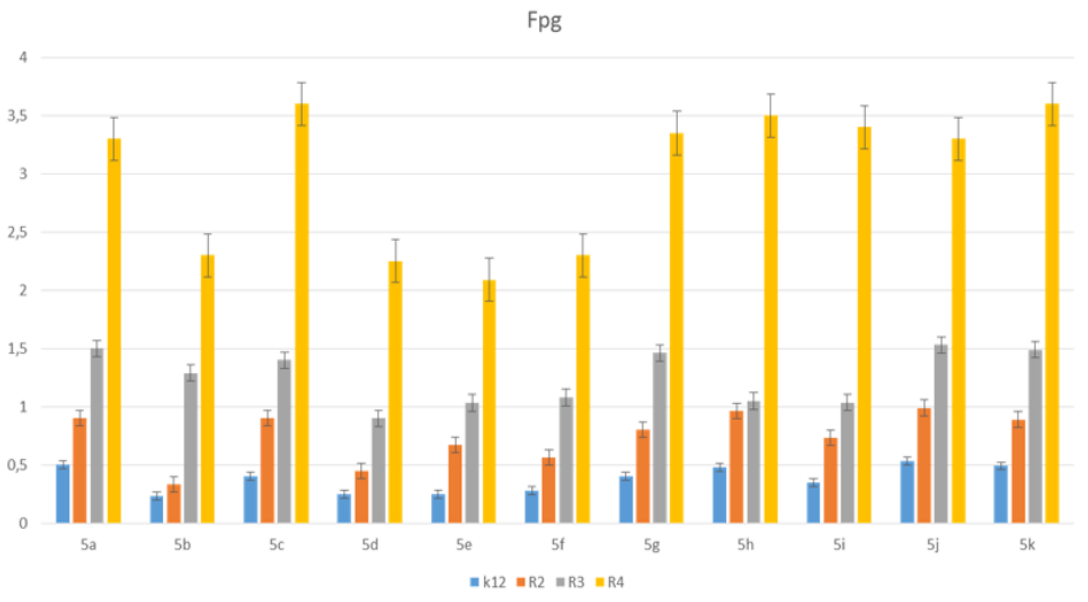
Figure 6. Percent of digested DNA damages recognised by Fpg enzyme- ( y -axis) with control K12 and R2–R4 strains ( x -axis); The selected compounds 1 – 17 were statistically significant at p < 0.05 *.